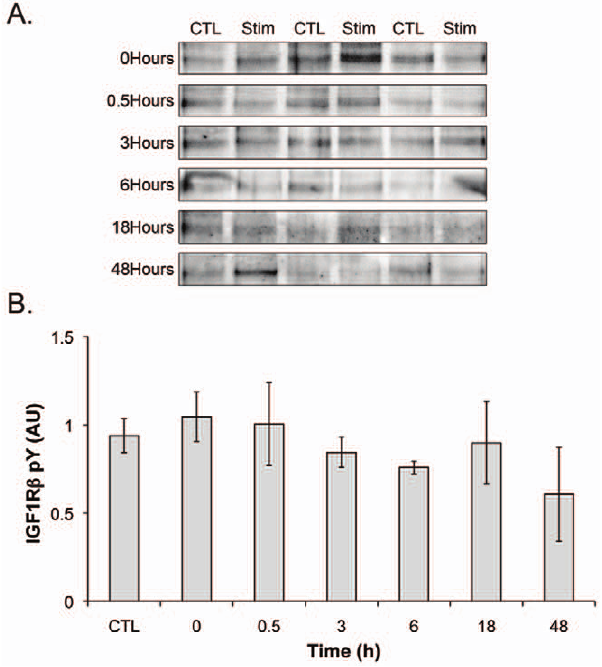
Figure 1. The IGF-1 receptor is not tyrosine phosphorylated following a single bout of resistance exercise. immunoblots. The IGF-1R was immunoprecipitated from the right and left TA muscles (n=3) following resistance exercise and the resulting western blot was probed with the pY20 phosphotyrosine antibody (A) and the immunoreactivity was quantified in panel (B).